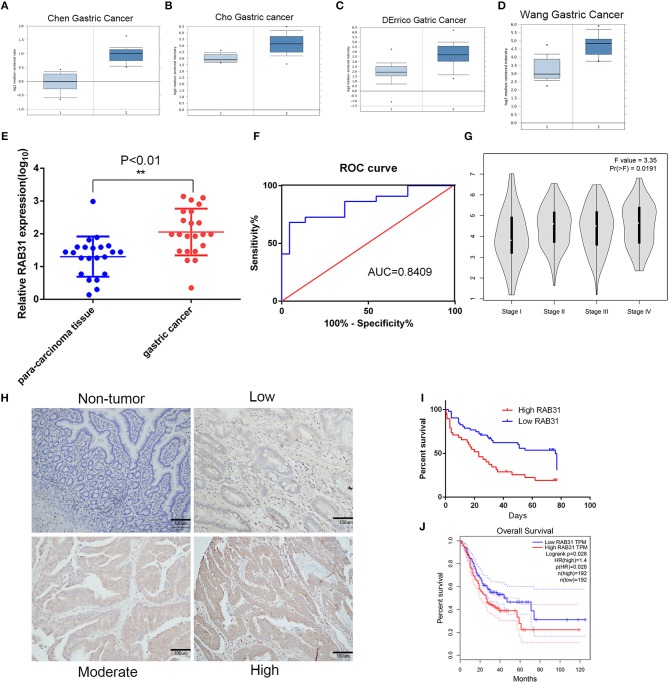
RAB31 is overexpressed in GC tissues and is positively correlated with poor prognosis. (A–D). Representative box plots of RAB31 expression from the Oncomine database (P < 0.001). (E) Expression level of RAB31 in cancer and para-carcinoma tissues of 22 patients as determined by qPCR (P < 0.01). (F) The receiver operating characteristic of specificity and sensitivity was created to assess potential predictive values. (G) The different expression levels of RAB31 in different stages of GC are shown by the violin plot, P < 0.05. (H) Representative IHC images of RAB31 staining in gastric tumor and non-tumor tissues (scale bar, 100 μm). (I) Overall survival analysis of GC patients with low versus high RAB31 expression. Survival rate was calculated by Kaplan–Meier survival analysis (n = 90; P < 0.001, log-rank test). (J) Survival curve was created using the GEPIA tool (P < 0.05).